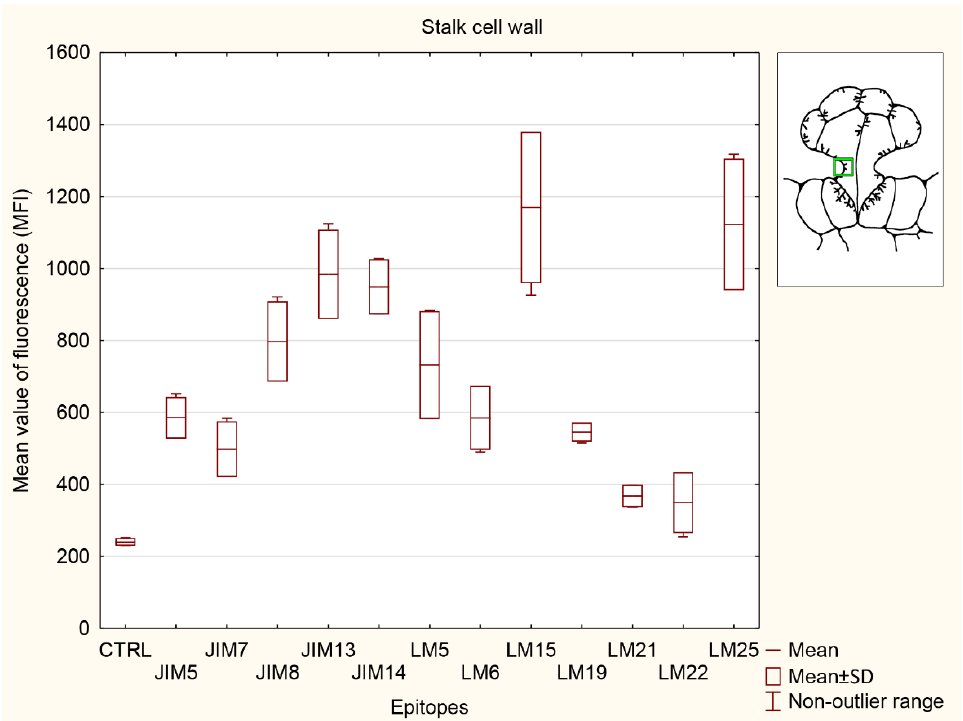
Figure 9. Quantification of immunofluorescence labeling for the stalk cell wall. Mean values of AGP fluorescence intensity (MFI) for negative control reaction (CTRL) and for labeled AGPs (JIM14, JIM8, and JIM13 epitopes), pectins (JIM5, JIM7, LM5, LM6, and LM19 epitopes), hemicelluloses (LM15 and LM25 epitopes), and heteromannans (LM21 and LM22 epitopes) in 3 glands from 3 different traps (n = 3).